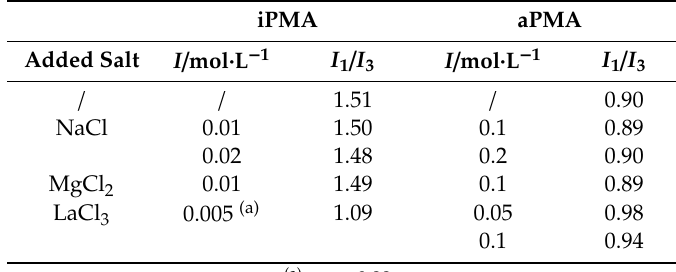
Table 4. The intensity ratio ( I 1 / I 3 ) of vibrational peaks in the fluorescence emission spectrum of pyrene in iPMA ( α N = 0.19) and aPMA ( α N = 0) solutions in aqueous NaCl, MgCl 2 and LaCl 3 with di ff erent ionic strength I . iPMA aPMA iPMA Added